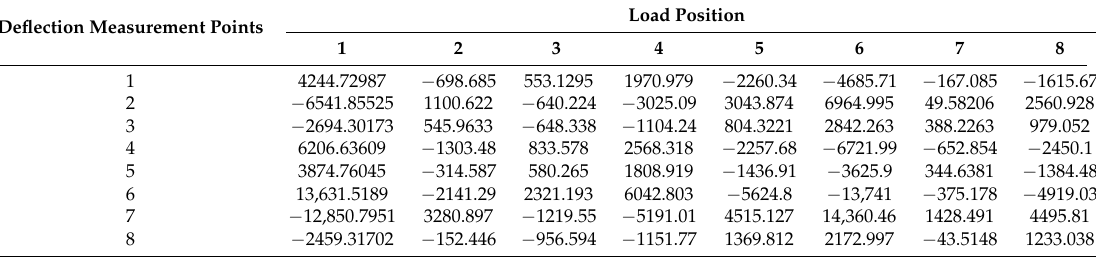
Table A1. Calculated K